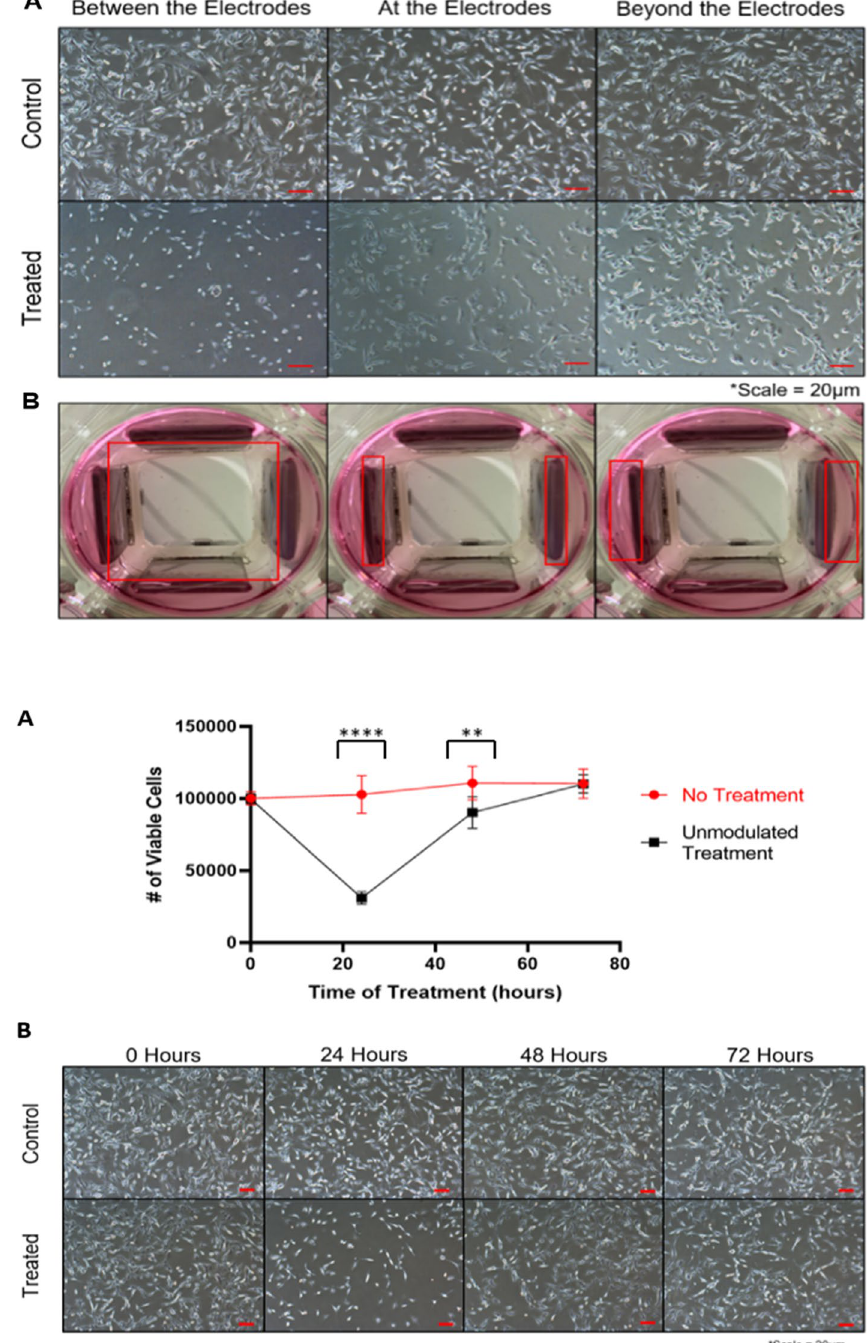
Fig. 4 Cell numbers reduced within field following 24 h of TTField treatment. A, B Micro- scope images of treated cells show that cells within the treatment area (between the electrodes) have much lower confluence than those outside of the treatment area (beyond the electrodes)